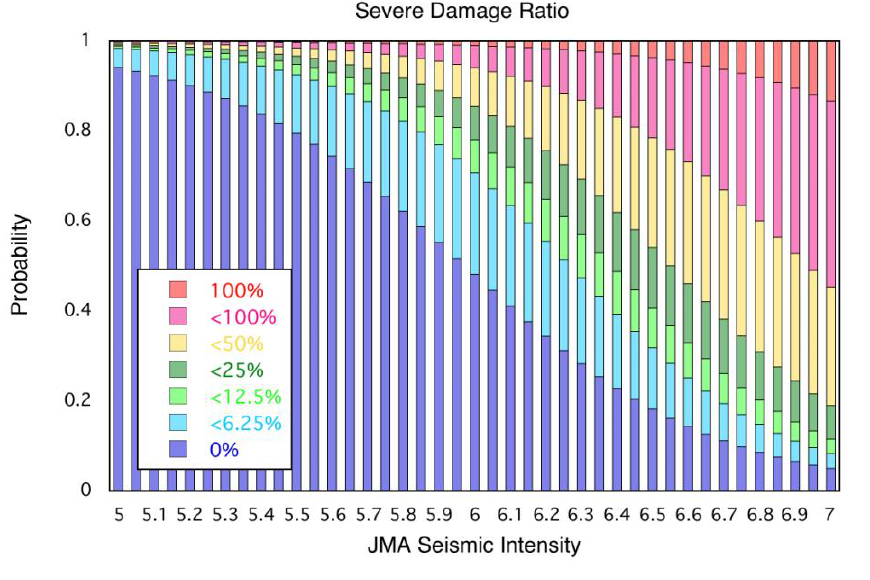
(JERS) and Z (ERS), and the Rj R